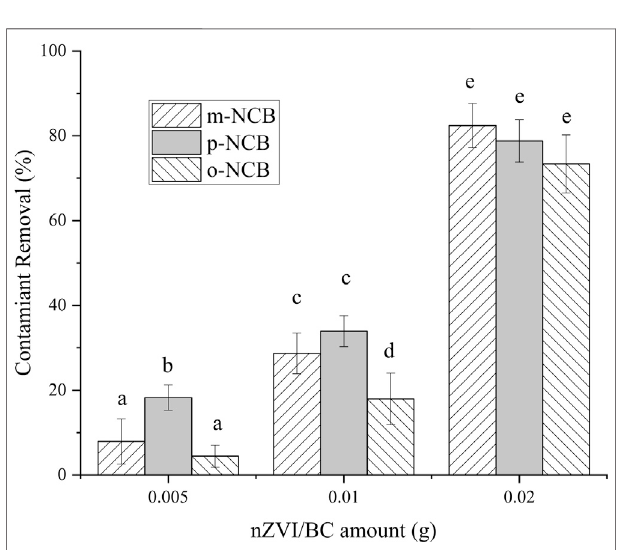
FIGURE 5 | Effect of activator dosage on NCB degradation. The Fe/PS molar ratio 1:1, the initial NCB isomer concentration 10 mg L − 1